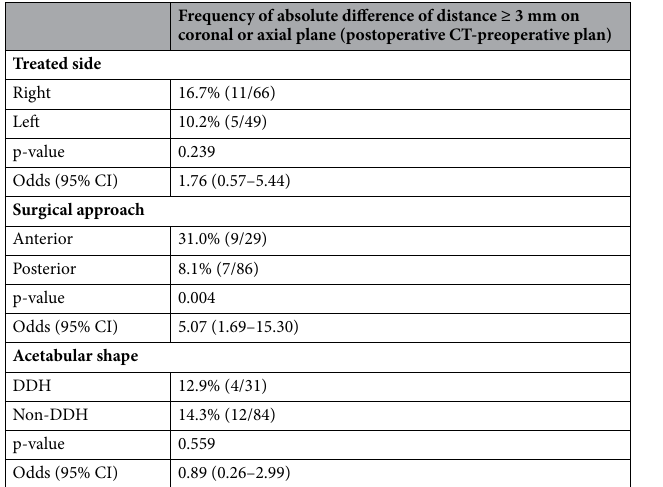
Table 5. Results of 3D cup position accuracy.